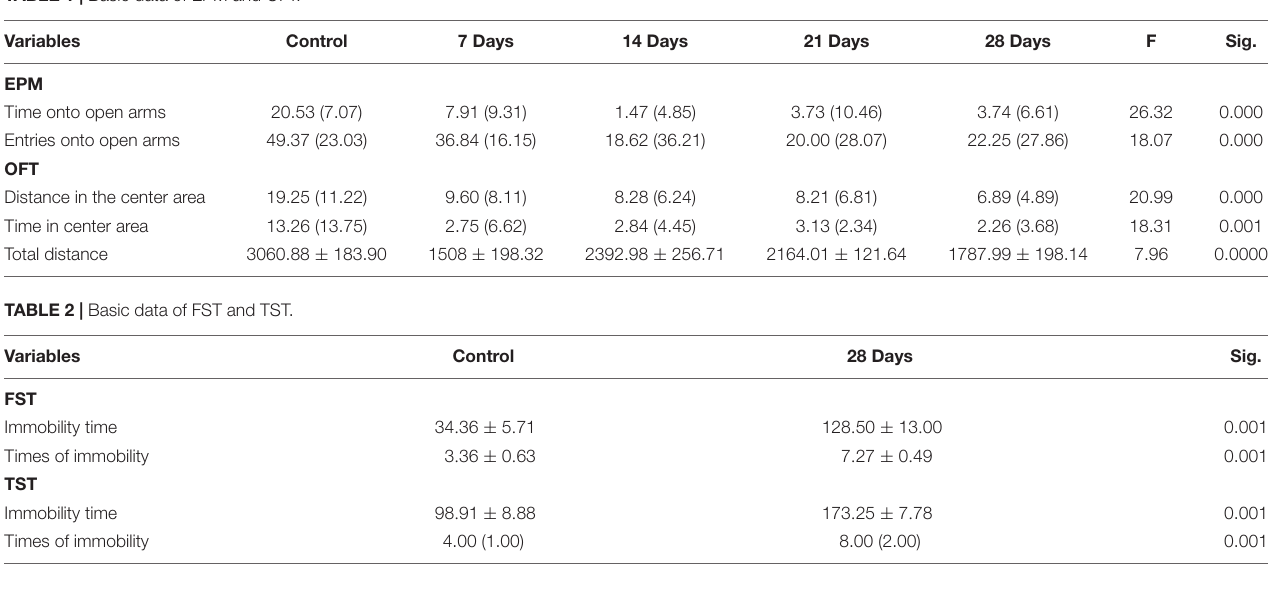
FIGURE 4 | MWM test showed that the spatial memory of CEBS mice was impaired. Quadrant division of MWM (A) . The learning ability change was evaluated in the place navigation stage (B) . Trajectory diagram of control group and CEBS group in the spatial probe stage (B) . Entries onto platform (D) , Distance (E) and time (F) in the target quadrant were used to evaluate the spatial memory ability. Data are presented as mean ± SEM or median (Interquartile range, IQR) from n = 6 mice/group (C–F) , ns P > 0.05, * P < 0.05. TABLE 1 | Basic data of EPM and OFT.